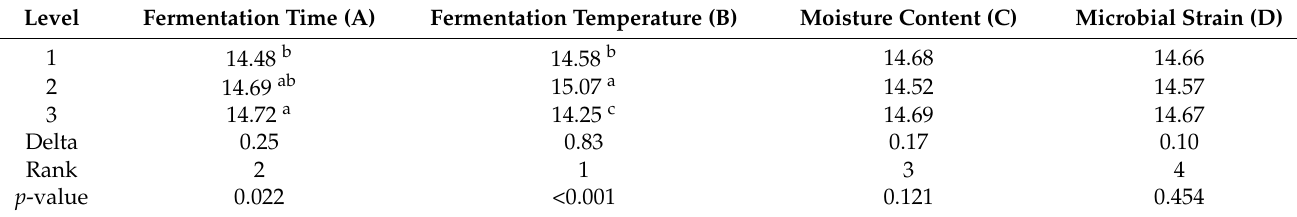
Table 3. Effects of different factor levels on CP of TMR with CSM.